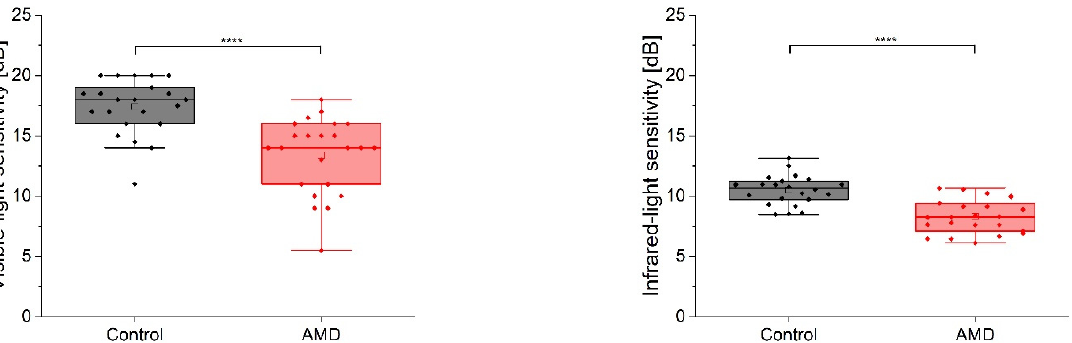
Figure 4. Two-group comparison for visible (left panel) and infrared light (right panel) sensitivity assessment. The box width indicates the interquartile range. The whiskers denote the fifth and 95th percentiles; the open squares refer to the mean value; and solid lines indicate the median level; points are individual data. **** p < 0.001.